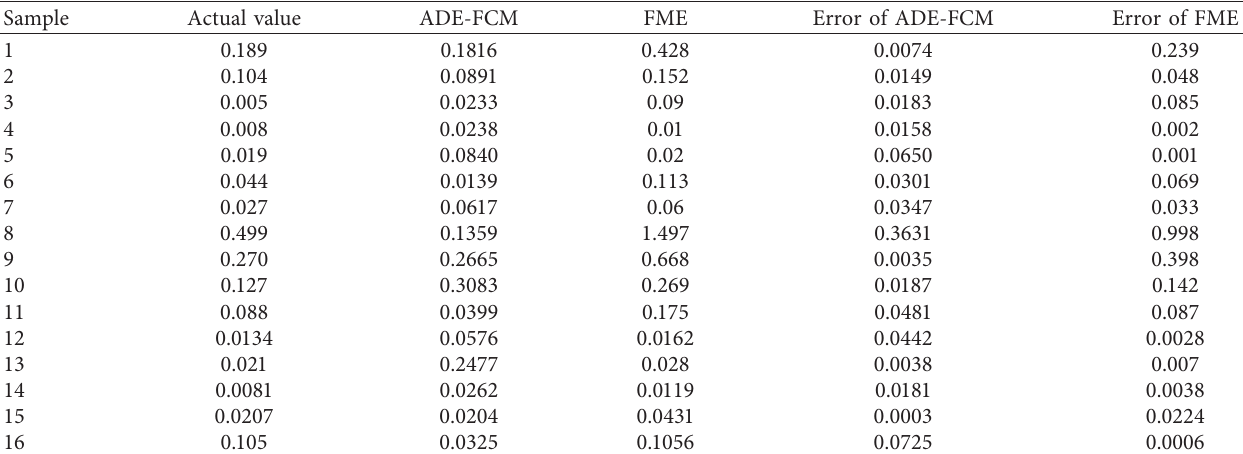
Table 3: Results estimated by different models.